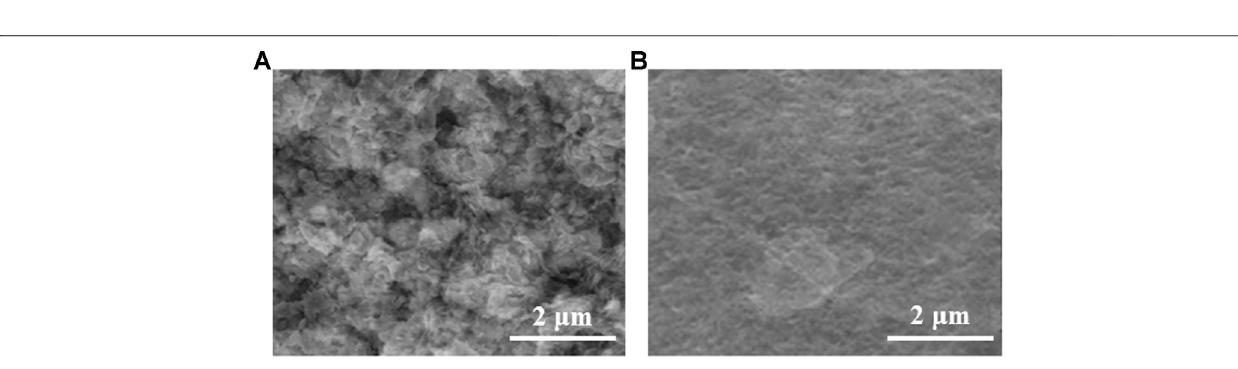
FIGURE 2 | SEM images of (A) soil particles and (B) polydopamine-graphene encapsulated soil particles on the electrode surface.